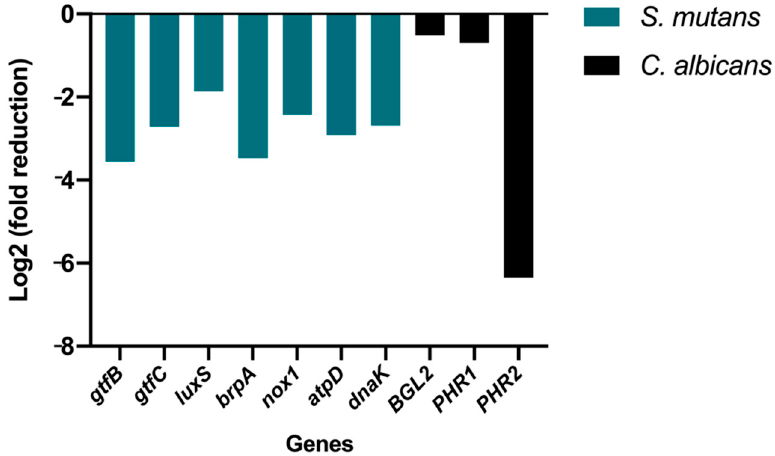
Figure 8. Gene expression in S. mutans and C. albicans after treatment with